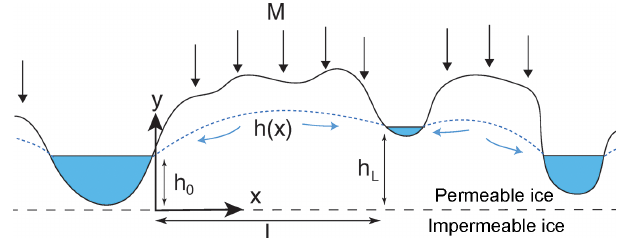
Figure 8. Schematic diagram of subsurface meltwater porous flow through weathering crust and permeable near-surface low-density ice to estimate interfluve transport speed v h . Melt generated at the near surface at rate M percolates through porous ice, supplying a water table that transports melt downhill towards streams at heights h 0 and h L above a layer of impermeable ice (dashed